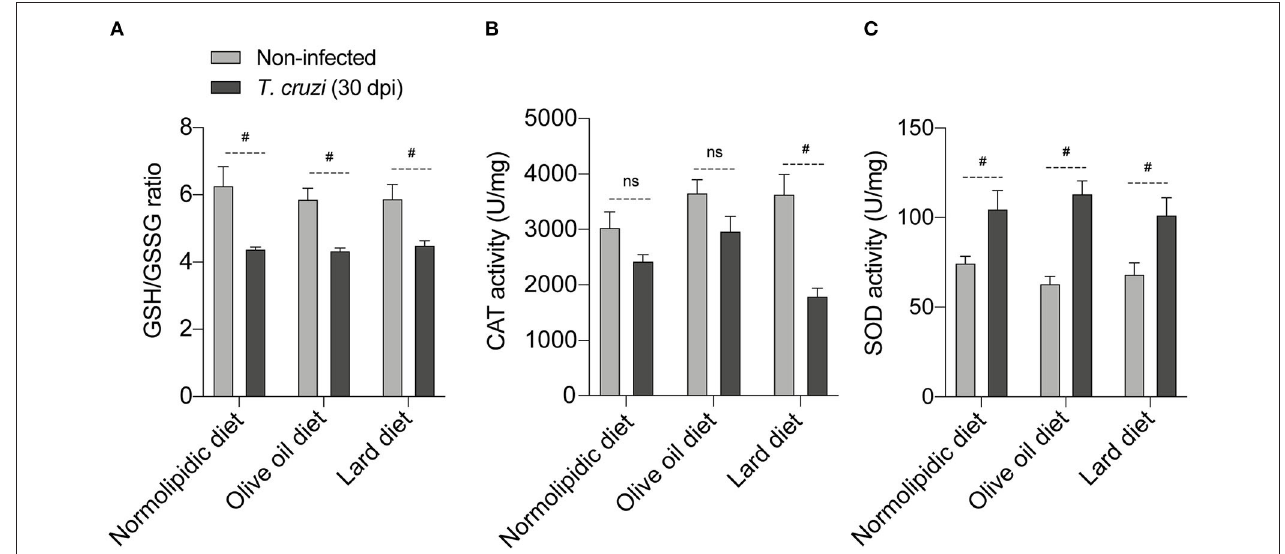
FIGURE 6 | Redox status of T. cruzi infected mice fed with different types of hyperlipidic diets. Newly weaned C57BL/6 mice were fed with either a normolipidic diet ( n = 5), monounsaturated fatty acid diet with olive oil ( n = 5) or saturated fatty acid diet with lard ( n = 5). At the day 60 of diet, mice were intraperitoneally infected with 50 blood trypomastigote forms of T. cruzi Colombian strain. After 30 dpi (A) the GSH/GSSG ratio, (B) CAT activity and (C) SOD activity were measured in the supernatant of a macerated piece of liver. GSH, reduced glutathione; GSSH, oxidized glutathione; CAT, catalase; SOD, superoxide dismutase; ns, not statistically different; # p < 0.05 by student t